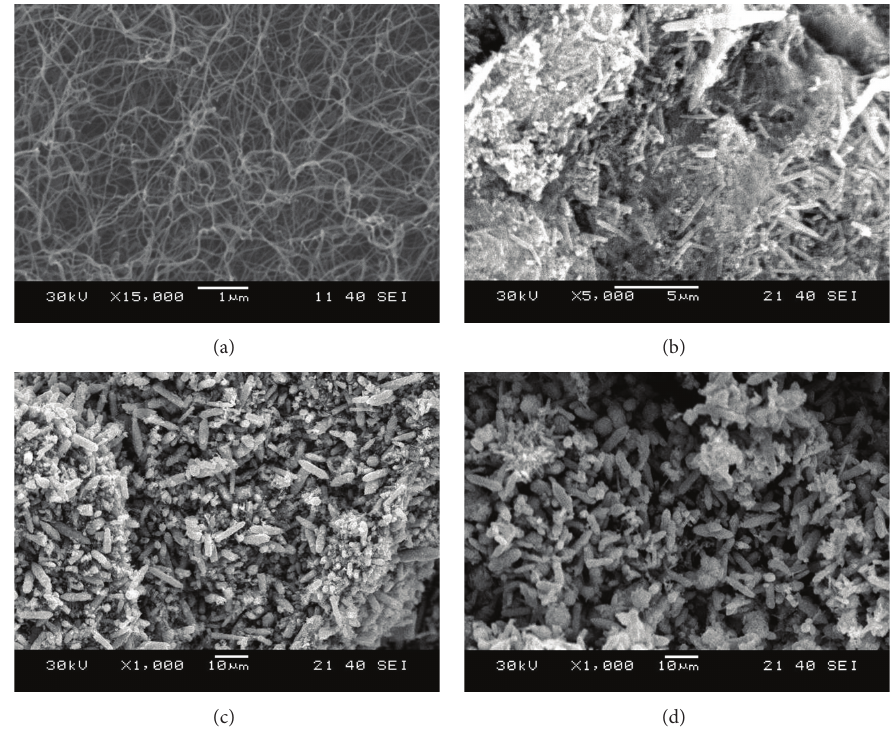
Figure 4: (a) SEM of bacterial cellulose and ((b)–(d)) samples prepared at 120 ∘ C with CdS contents at 10%, 20%, and